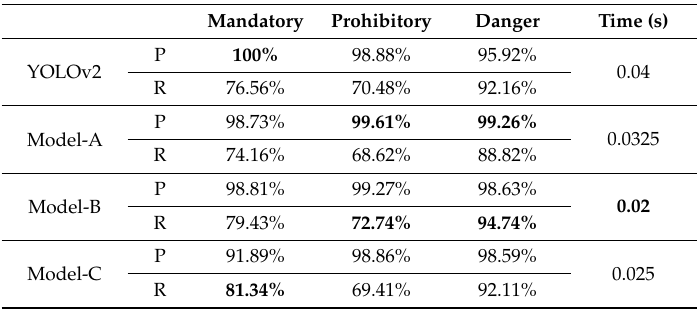
Table 3. The results of improved models in the CCTSDB ( t =